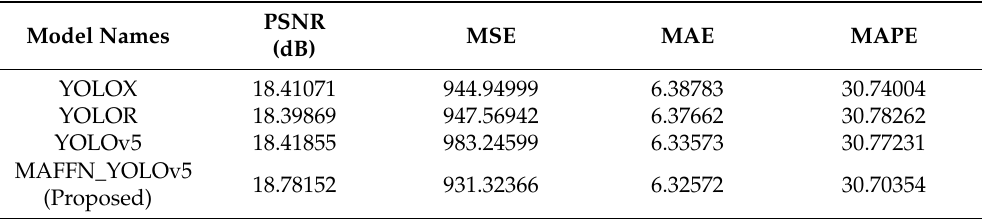
Table 4. Comparison of Error Evaluation performance metrics calculated for various object detection models with the proposed model.